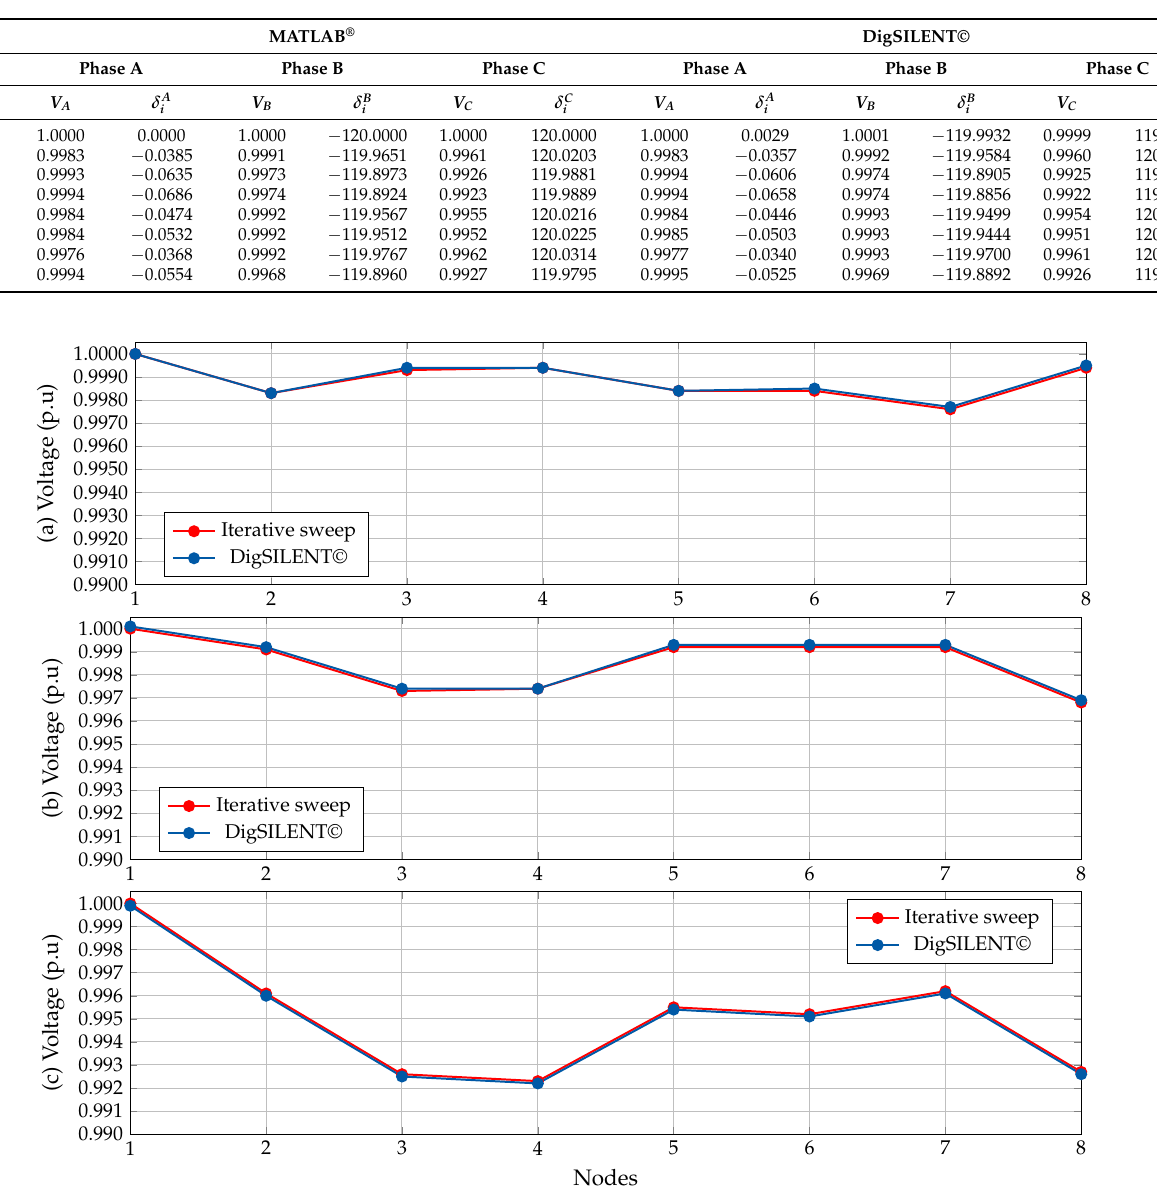
Table 4. Nodal voltage per phase in the 8-node test system.